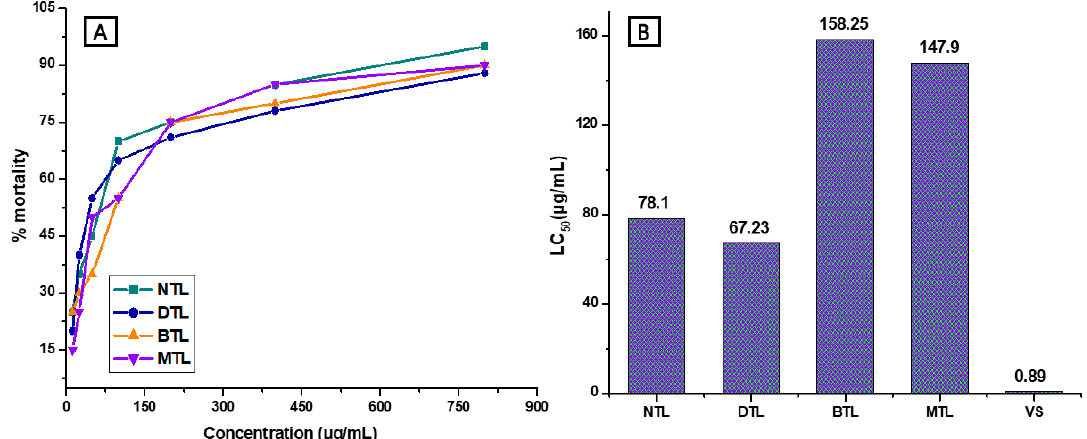
Figure 2. Cytotoxic effects of the methanol extract of the T. leucostaphylum leaves and its derived fractions against brine shrimp naupli. ( A ): Relation between extract concentration and percentage mortality; ( B ): LC50 values for cytotoxicity assay. NTL = n -hexane fraction of T. leucostaphylum ; DTL = dichloromethane fraction of T. leucostaphylum ; BTL = n -butanol fraction of T. leucostaphylum ; MTL = methanol extract of T. leucostaphylum ; vs. = vincristine